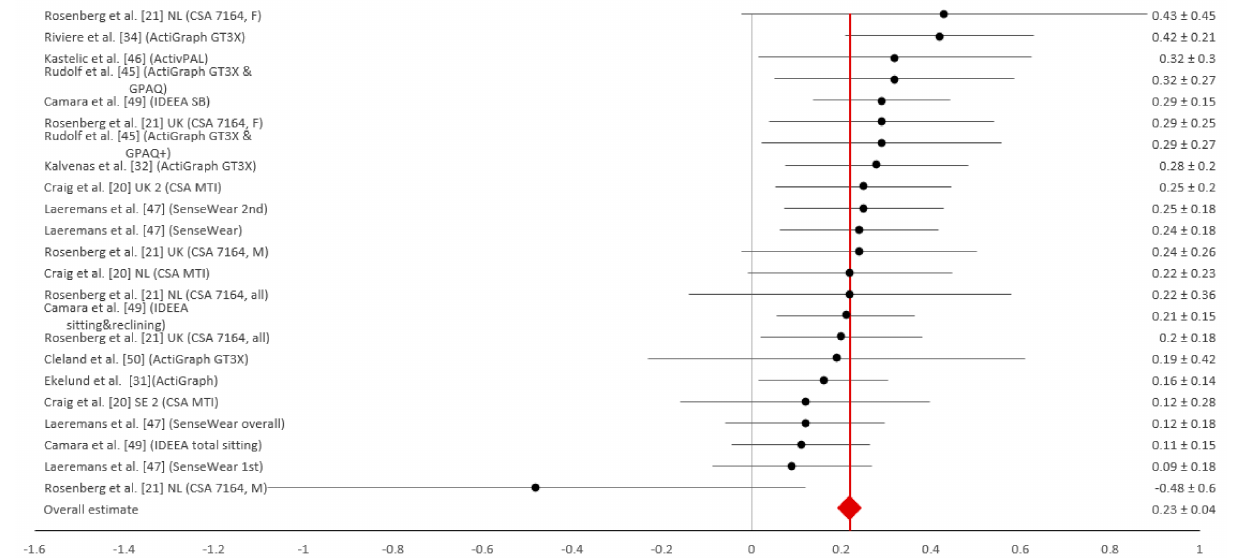
Figure 4. Forest plot of criterion validity coefficients with 95% confidence intervals. Notes: B—Belgium; FI—Finland; NL—The Netherlands; PT—Portugal; SE—Sweden; UK—United Kingdom; SB—sedentary behaviour; IDEAA— Intelligent Device for Energy Expenditure and Activity; M—male; F—female.